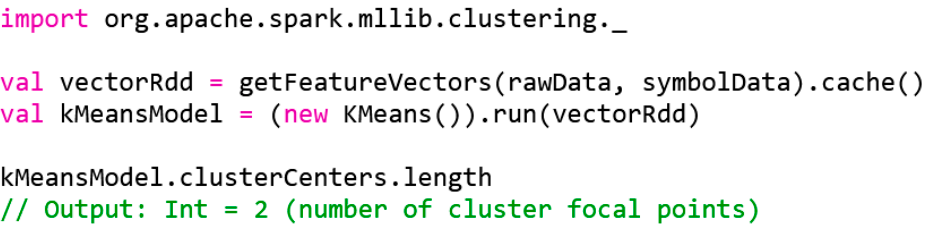
Figure 9. k-means model generation.